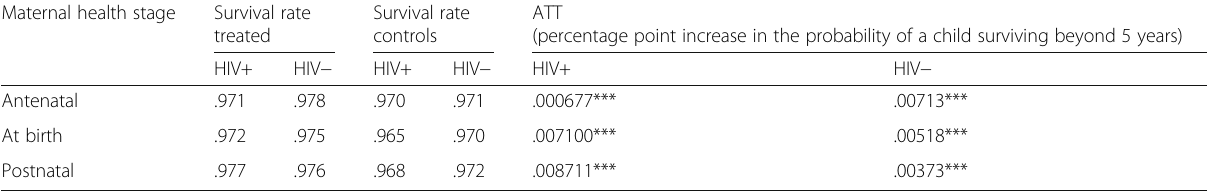
Table 2 Average treatment effect on the treated (ATT) results Maternal health stage Survival rate Survival rate ATT treated controls (percentage point increase in the probability of a child surviving beyond 5